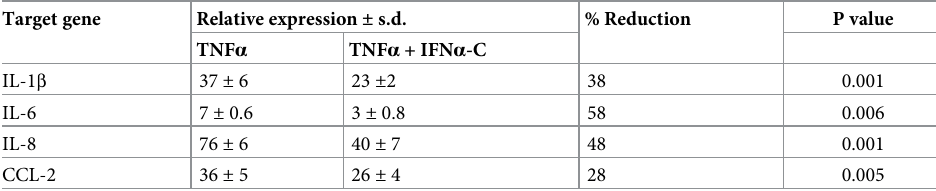
ARPE-19 cells were treated with IFN α -C (3 μ M) for 2 hr, followed by treatment with TNF (50 ng/ml) for 4 hr. RNA extraction and qPCR were carried out as in Table 1 . Analysis was done using β -actin as a control. The results represent the average of three independent